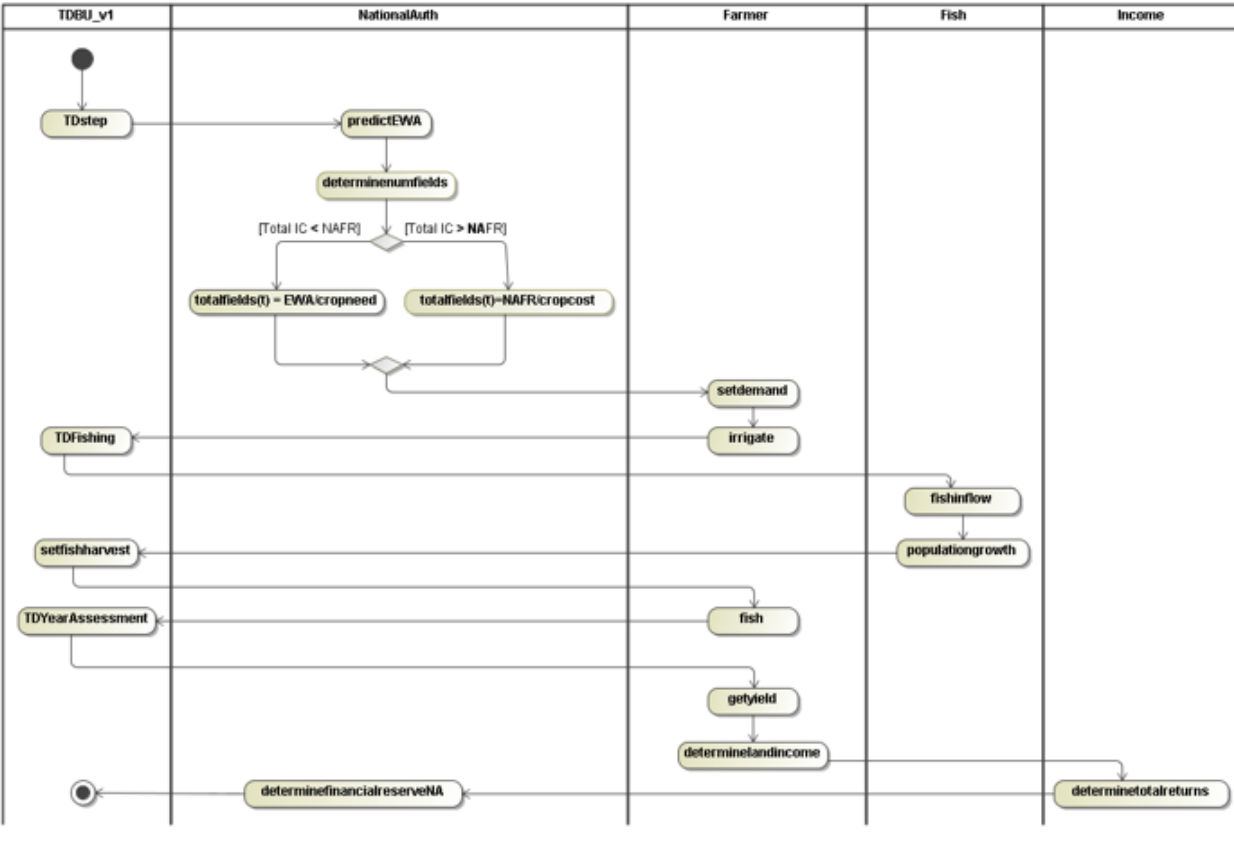
Fig. 5. Activity diagram of the centralized model. Sequence of activities within 1 yr (t). EWA(t)= expected water availability in mo 7 of yr t, RWV(t)= requested water volume in mo 7 of yr t, Total IC = total costs of irrigating the total amount of fields, NAFR = Financial Reserve of the National Authority, cropneed = water needed to irrigate one field of the respective crop, and cropcost = cost of cultivating the crop on one